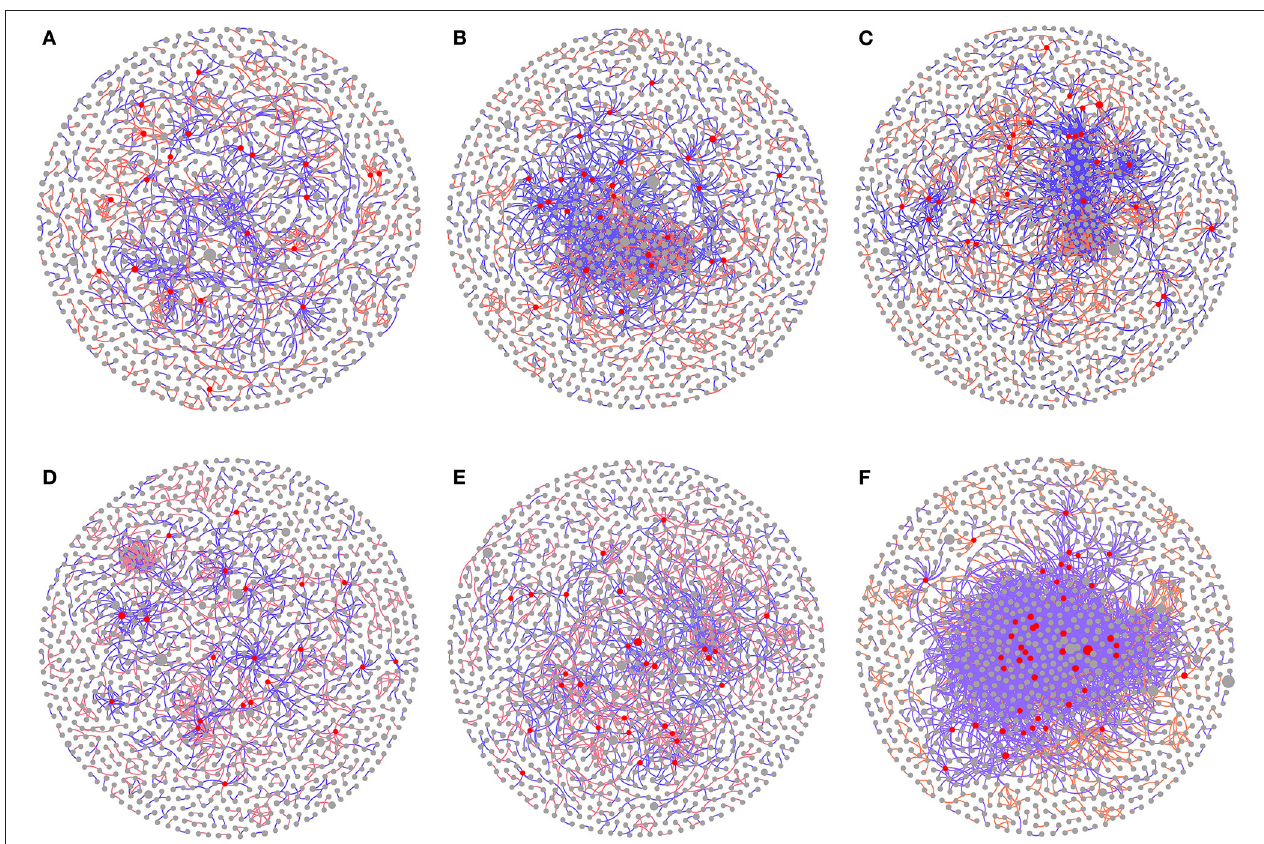
FIGURE 6 | Effect of different amounts of corn straw returned to the field on soil bacterial coexistence network. (A) CK treatment in the wheat season. (B) HSR treatment in the wheat season. (C) SR treatment in the wheat season. (D) CK treatment in the corn season. (E) HSR treatment in the corn season. (F) SR treatment in the corn season. Nodes represent bacterial OTUs. Node colors correspond to their topological role in the network. Red is the core microorganism. The node size corresponds to the relative abundance of the OTU. The blue lines indicate positive correlation, and the red lines indicate negative